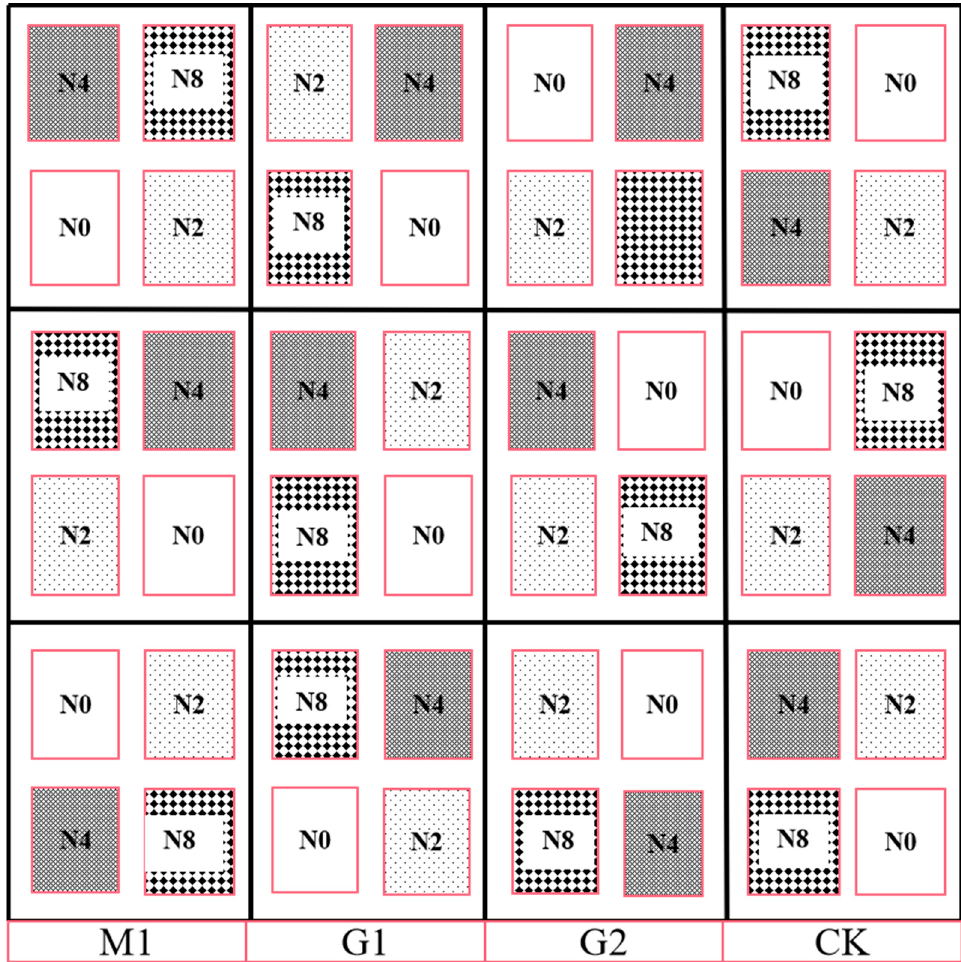
Figure 1. The layout of the treatment plots: (M1) Mowing area; (G1) Lightly grazed area; (G2) Heav- ily grazed areas; (CK) Control area. Different patterns of filling represent nitrogen deposition (N0: 0 g N m − 2 yr − 1 , N2: 2.706 g N m − 2 yr − 1 , N4: 5.412 g N m − 2 yr − 1 , N8: 10.824 g N m − 2 yr − 1